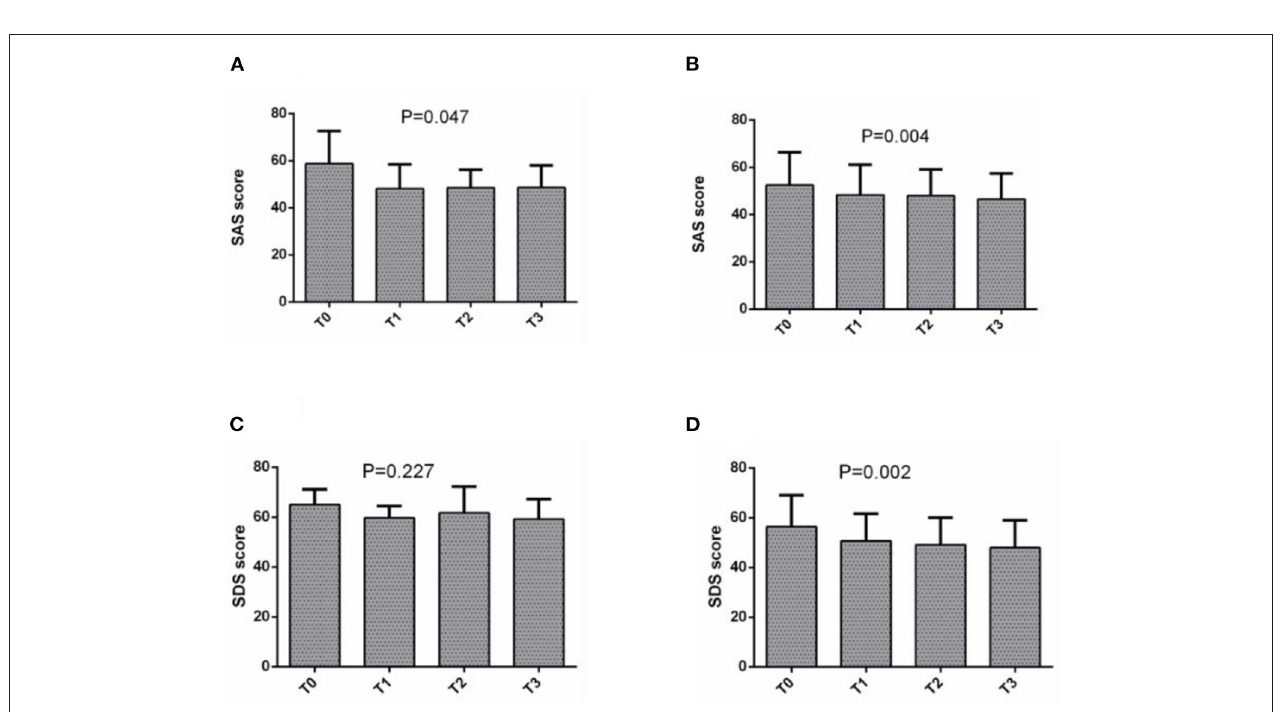
and the number of confirmed cases was 68,135